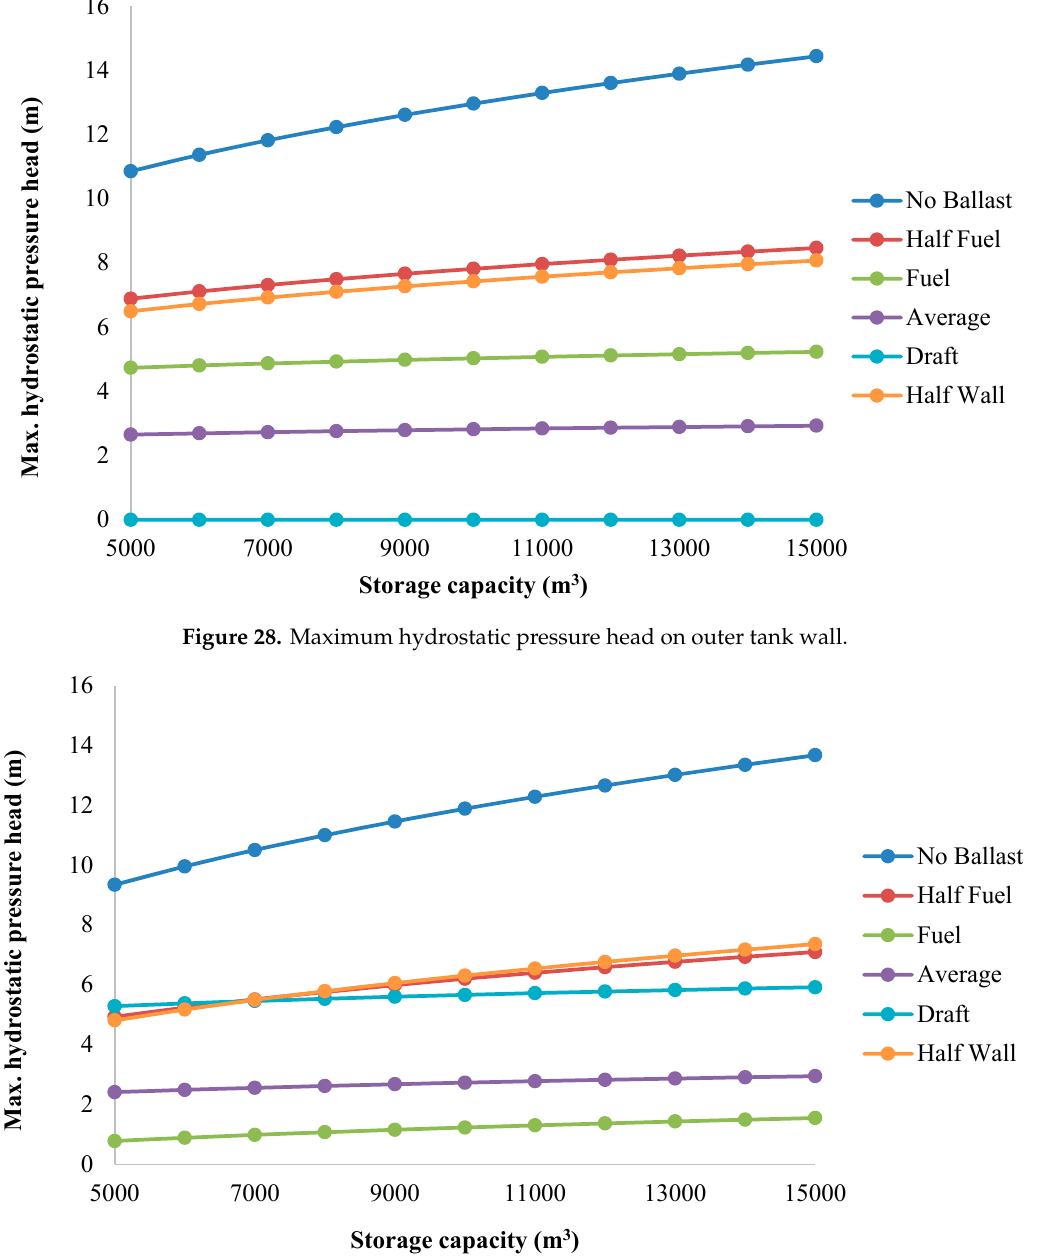
Figure 29. Maximum hydrostatic pressure head on inner tank wall.